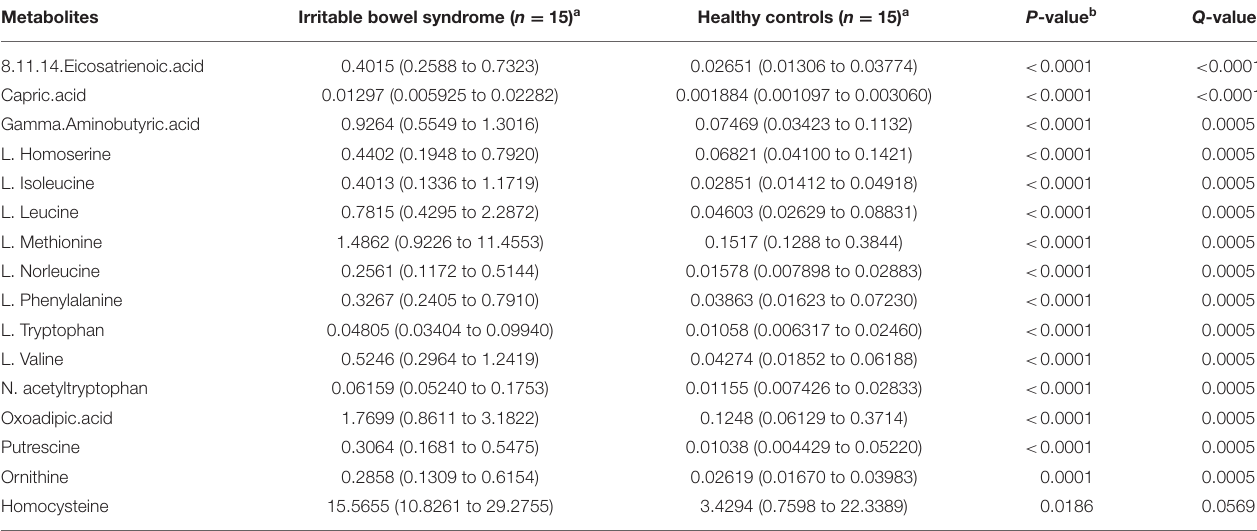
TABLE 2 | Major differentially abundant fecal metabolites (abundance%) in IBS patients and healthy control. Metabolites